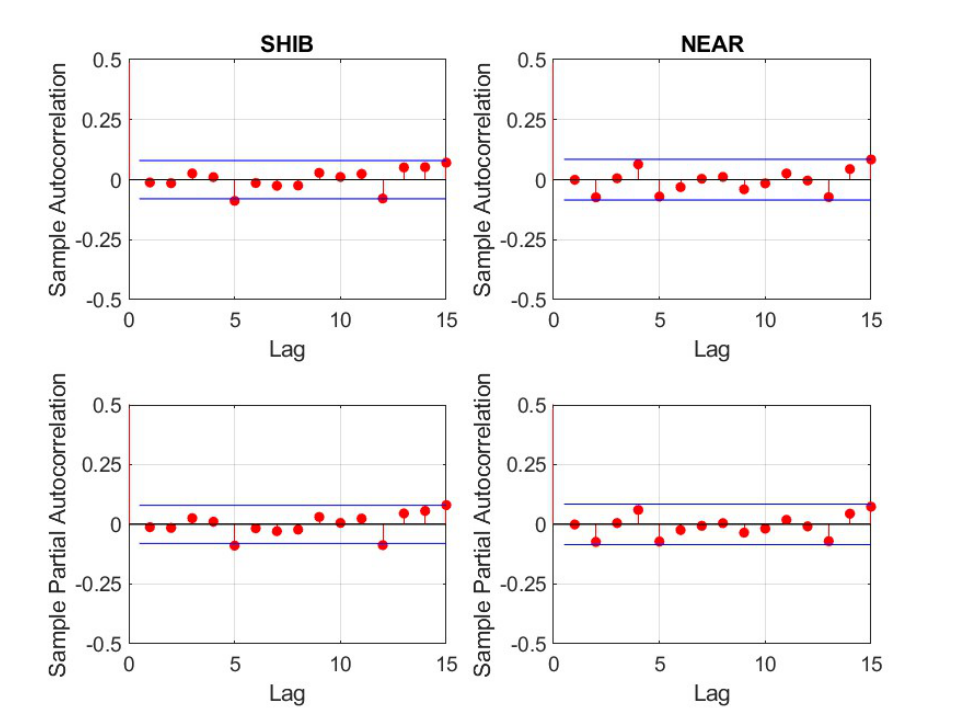
Figure A13. SHIB’s and NEAR’s residuals’